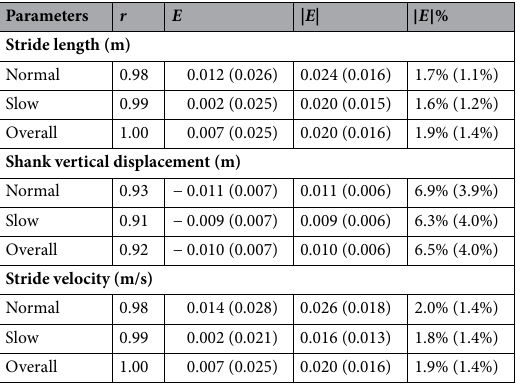
Table 1. Pearson’s correlation coefficient ( r ), the mean (SD) of error ( E ), absolute error (| E |), and relative absolute errors ( | E | % ) for the gait parameters extracted from the proposed method and motion capture